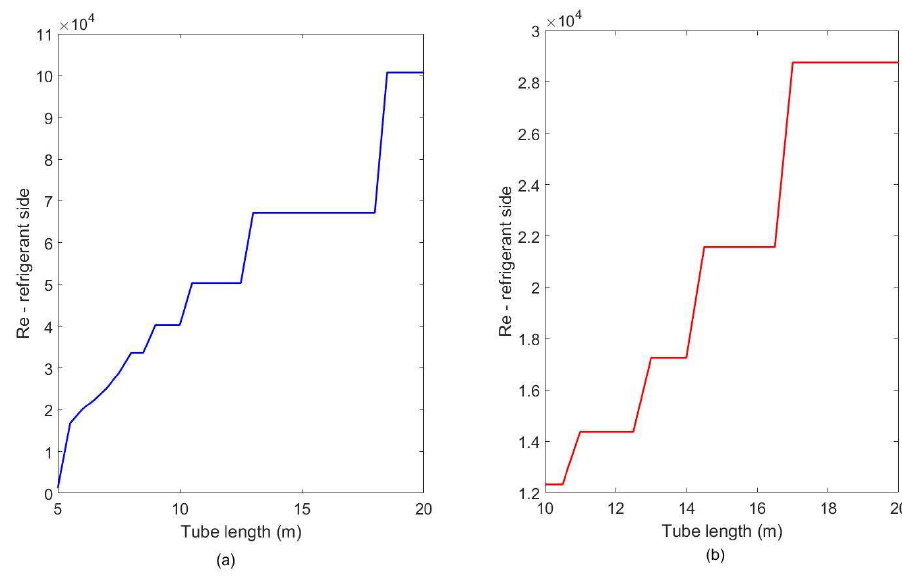
Figure 10. Reynolds number refrigerant side ( a ) outside diameter of 7.35 mm; and ( b ) outside diameter of 18.5 mm.